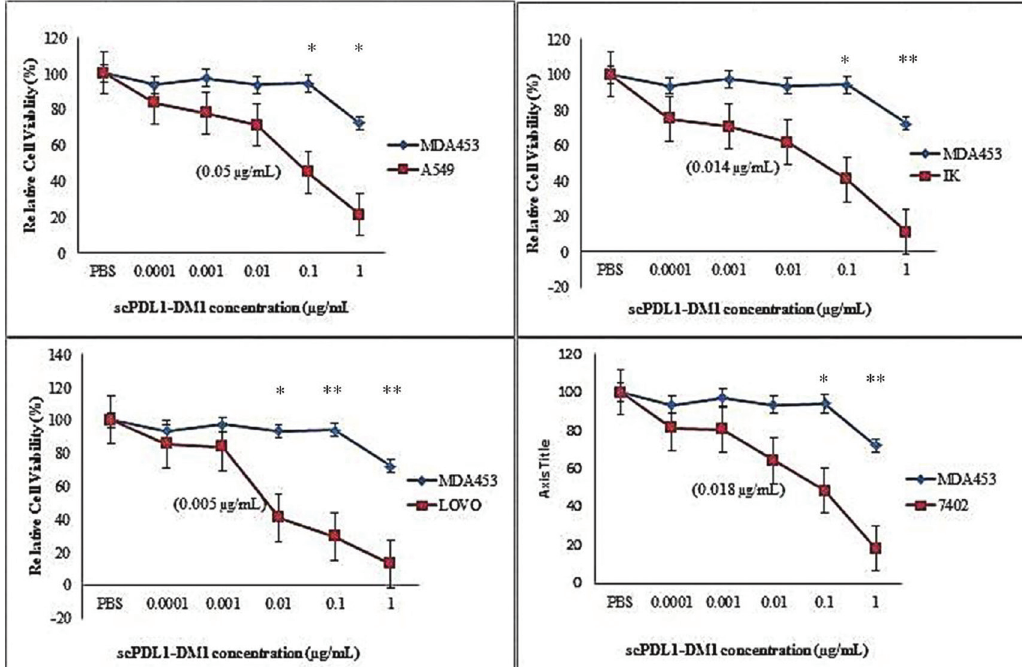
Figure 6 - Cell viability detection after 72 hours by MTT analysis. After incubation of 72 hours, the scPDL1-DM1 conjugate shows the potent anti-proliferative effect on PD-L1 positive tumor cells (A549, IK, LOVO, and 7402) but has no effect on PD-L1 negative MDA453 cells. MDA453 cells wereusedascontrol.Thesecellswereincubatedin96wellsplateindrugconjugatefor72hours.TheIC50valuesforeachcelllineareshowninparenthe- ses.Thetestexperimentswererepeatedthreetimesasindicatedinstandardbars.One-wayANOVAwasusedtoanalyzethecellviabilityafter48hoursof